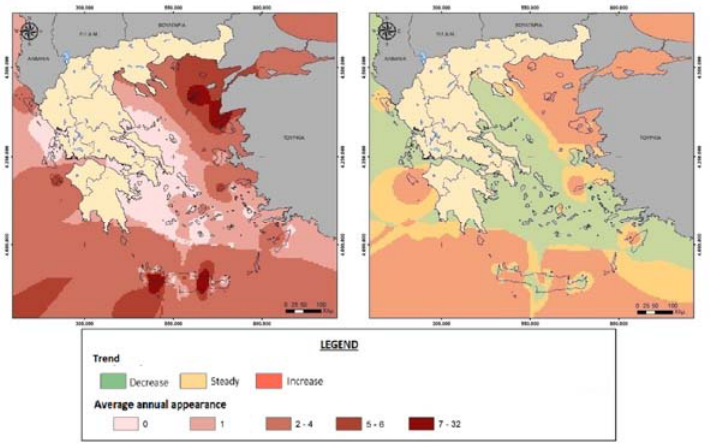
Figure 2. Frost frequency and